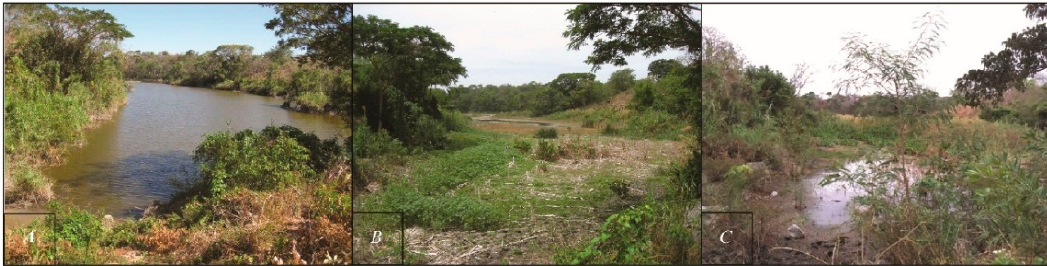
Figure 2. El Gancho lake level and vegetation cover. ( A ) Pre-El Nino Southern Oscillation: March 2014; ( B ) El Nino Southern Oscillation: May 2015; ( C ) Post- El Nino Southern Oscillation: March2017.